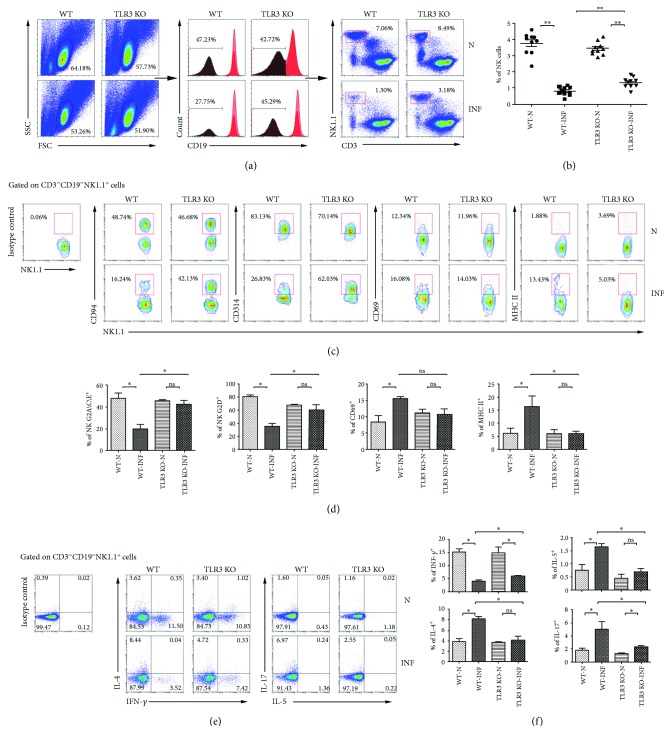
Characteristics of NK cells in S. japonicum-infected TLR3−/− mice. Female C57BL/6 wild-type mice (WI) and TLR3−/− mice (TLR3 KO) were infected with S. japonicum cercariae or not and sacrificed after 5 weeks. Splenic lymphocytes were isolated and stained by different fluorescent-labeled antibody and analyzed by FACS. (A/B) CD19− cell population was gated firstly. The percentage of CD3−NK1.1+ NK cells was analyzed. (a) A representative result is shown. (b) Statistical results of the percentage of NK cells in the spleen were calculated from FACS data. One syndrome represents an independent experiment. (c, d) The expression of MHC II, CD69, NKG2A/C/E, and NKG2D on NK cells of mice from both the normal and infected WT and TLR3 KO mouse spleen were detected. (c) A representative result is shown. (d) Statistical results of at least three independent experiments are shown. (e, f) Splenic lymphocytes were stimulated with PMA plus ionomycin for 5 hours, stained by the means of intracellular staining, and analyzed by flow cytometry. The expressions of IFN-γ, IL-4, IL-5, and IL-17 on NK cells from different groups are shown. (e) A representative result is shown. (f) The statistical results of at least three independent experiments are shown. Data are shown as mean + SEM of 3–5 samples from three independent experiments. ∗P < 0.05 and ∗∗P < 0.01; ns for P > 0.05. N: normal; INF: infected.